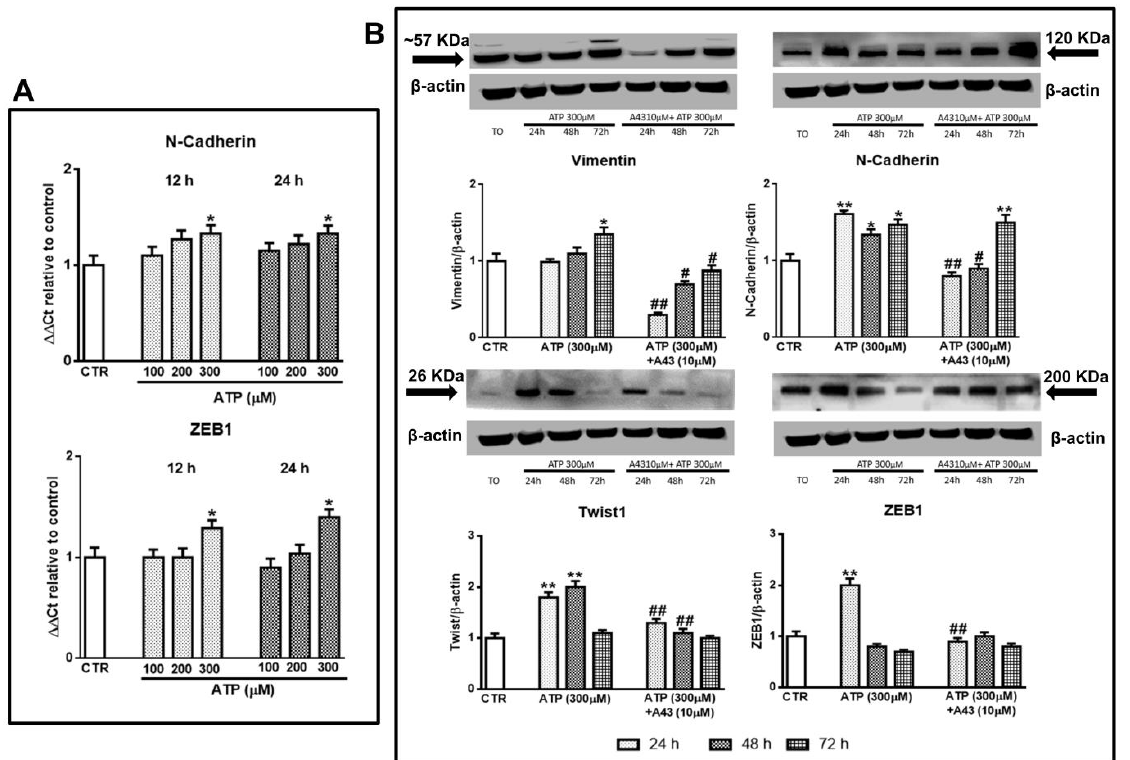
Figure 1. E ff ect of ATP on epithelial-to-mesenchymal transition (EMT) markers evaluated at di ff erent times after drug administration to cultured glioblastoma stem cells (GSCs). GSCs, cultured up to their confluence in vitro were exposed to di ff erent concentrations ( A ) or 300 µ M of ATP ( B ), in the presence or not of the P2X7R antagonist, A438079, added to the cultures 1 h prior to ATP. ( A ) At the indicated time periods cells were collected and mRNA was extracted and analyzed for the gene expression of N-cadherin and ZEB1. mRNA levels were normalized ( ∆ Ct) by using the house keeping GAPDH as endogenous control and the results were obtained by relative quantitation among groups using the comparative 2 ∆∆ Ct method. Values, calculated as fold of increase vs. untreated cells assumed as control (CTR) are the mean ± S.E.M. of three independent experiments where each sample was tested in duplicate. ( B ) cells, harvested at the indicated time periods, were lysed and the protein levels of EMT markers such as vimentin, N-cadherin, Twist1, and ZEB1 were determined by western blot analysis. Immunoblots were re-probed with an antibody against β actin, quantified by densitometric analysis, normalized to β actin used as an internal control, and reported in the histograms assuming the value of control / β -actin = 1. Immunobands in the figure are representative of independent experiments carried out in GSCs #1 and tested in triplicate. Of note, the band of β -actin is the same for all blots reported in the figures, which were obtained by cutting the same membrane at di ff erent heights corresponding to the molecular weights of the selected markers. * p < 0.05, ** p < 0.01: statistical significance vs. untreated GSCs assumed as control (CTR); # p < 0.05, ## p < 0.01: statistical significance vs. cells exposed to ATP (one-way ANOVA plus Dunnett’s test).